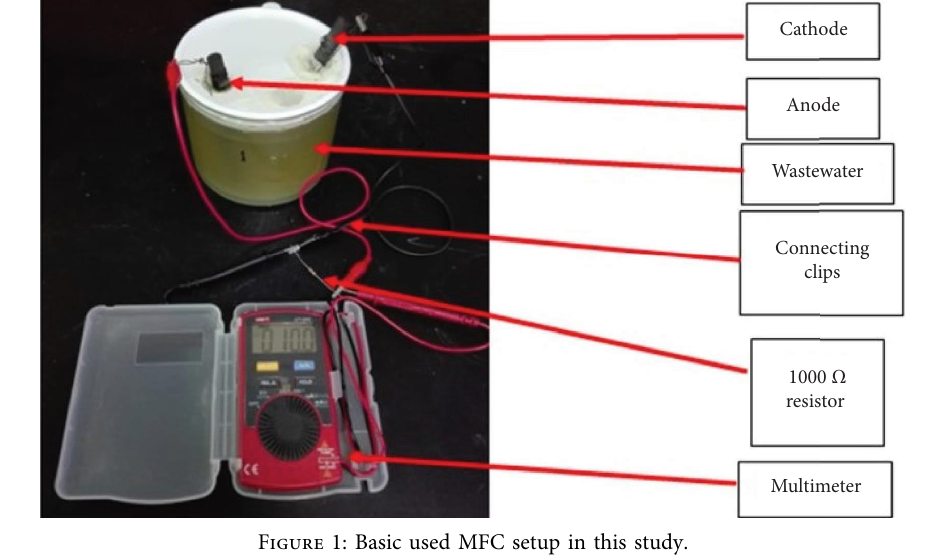
Figure 1: Basic used MFC setup in this